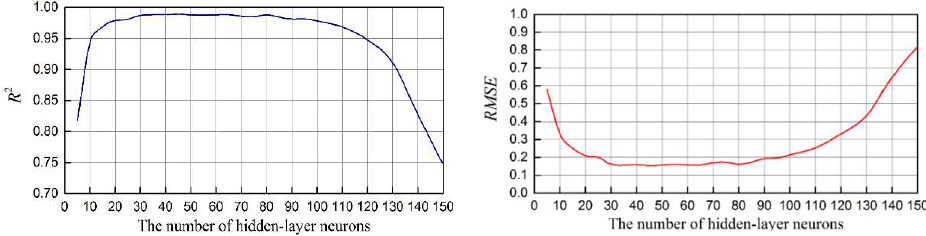
Figure 7. The effect of the number of hidden-layer neurons on ELM performance.